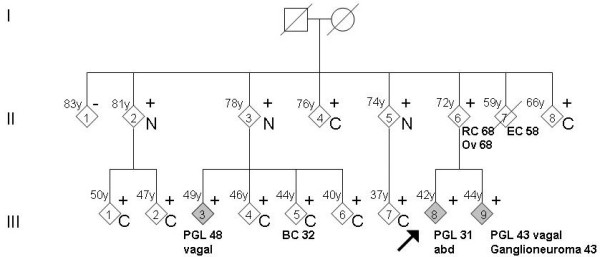
Pedigree with clinical data. The arrow shows the index patient. The non-carriers have been collapsed to minimize recognition of the pedigree.+, mutation present; -, mutation absent; C, clinical screening; N, no symptoms (but not screened); RC, rectal carcinoma; Ov, ovarian carcinoma; EC, endometrial carcinoma; BC, breast cancer (tumors with age at diagnosis in years).